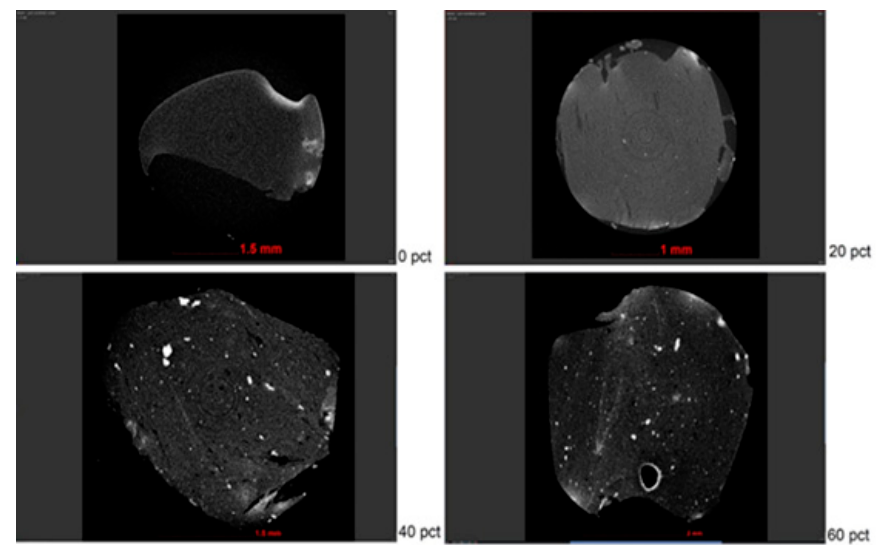
Figure 8. Transverse (top views) of SA hydrogels under differing integrations of HA (0%, 20%, 40%, and 60%).